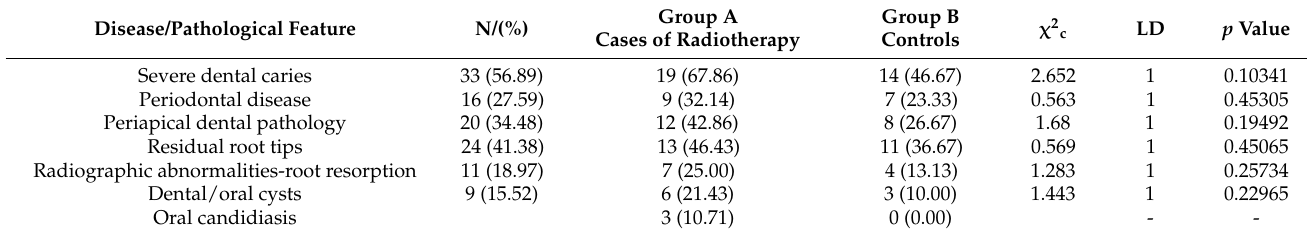
Table 8. The oro-dental morbidity of the study